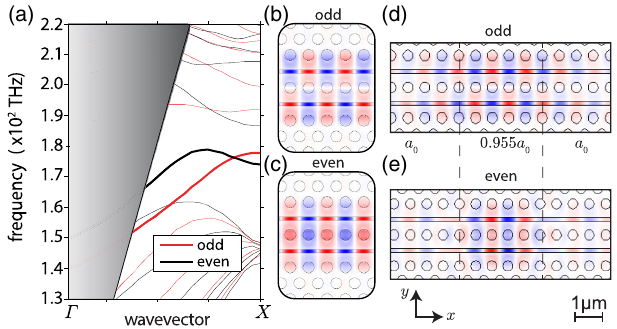
FIG. 2. (a) Band structure diagram of the periodic (along x ) double-slotted photonic crystal waveguide structure. Here, we show only photonic bands that are composed of modes with even vector symmetry around the “ vertical ” ( σ ) mirror plane. The two z waveguide bands of interest lie within the quasi-2D photonic band gap of the outer photonic crystal slabs and are shown as bold red and black curves. These waveguide bands are labeled “ even ” (bold black curve) and “ odd ” (bold red curve) due to the spatial symmetry of their mode shape for the dominant electric field polarization in the y direction, E . The simulated structure is y defined by the lattice constant between nearest-neighbor holes in the hexagonal lattice ( a 0 ¼ 480 nm), the thickness of the silicon slab ( d ¼ 220 nm), the width of the two slots ( s ¼ 100 nm), and ¼ 3 . 42 ). The hole the refractive index of the silicon layer ( n Si radius in the outer slabs and the central nanobeam is r ¼ 144 nm. The gray shaded region represents a continuum of radiation modes which lie above the light cone for the air cladding which surrounds the undercut silicon slab structure. (b) Normalized E y field profile at the X point of the odd waveguide supermode, shown for several unit cells along the x guiding axis. (c) E field y profile of the even waveguide supermode. Waveguide simulations of (a) – (c) are performed using the plane-wave mode solver MPB [32,33]. Normalized E field profile of the corresponding y localized cavity supermodes of (d) odd and (e) even spatial symmetry about the y axis mirror plane. The lattice constant a 0 is decreased by 4.5% for the central five lattice constants between the dashed lines to localize the waveguide modes. Simulations of the full cavity modes are performed using the COMSOL finite- element method mode solver package bands are of predominantly transverse (in-plane) electric field polarization, and are thus called TE-like. In the case of a perfectly symmetric structure, we can further classify the waveguide bands by their odd or even symmetry about the “ horizontal ” mirror plane ( σ ) defined by the y -axis normal FIG. 3. Tuning of the slot widths of the double-slotted photonic y and cutting through the middle of the central nanobeam. crystal cavity showing (a) the mean wavelength shift and (b) the splitting 2 J ¼ ω þ − ω − of the even and odd cavity supermodes The two waveguide bands of interest that lie within the versus slot width s ¼ s 1 ¼ s 2 . (c),(d) Avoided crossing of the quasi-2D photonic band gap of the outer photonic crystal cavity supermodes obtained by tuning s 1 while keeping s 2 fixed slabs, shown as bold red and black curves, are labeled at (c) s 2 ¼ 90 nm and (d) s 2 ¼ 95 nm. The red and black data “ even ” and “ odd ” depending on the spatial symmetry with points correspond to the supermode branch with even and odd respect to σ of their mode shape for the dominant electric y symmetry at the center of the anticrossing, respectively. Note that field polarization in the y direction, E (note that this y the upper and lower supermode branch switch symmetry between labeling is opposite to their vector symmetry). The E small slots ( s 2 ¼ 90 nm) and large slots ( s 2 ¼ 95 nm). For all y spatial mode profiles at the X point for the odd and even simulations in (a) – (d) the parameters of the cavity structure are waveguide supermodes are shown in Figs. 2(b) and 2(c), the same as in Fig. 2, except for the slot widths. The simulations respectively. are performed using the COMSOL FEM mode solver [34].